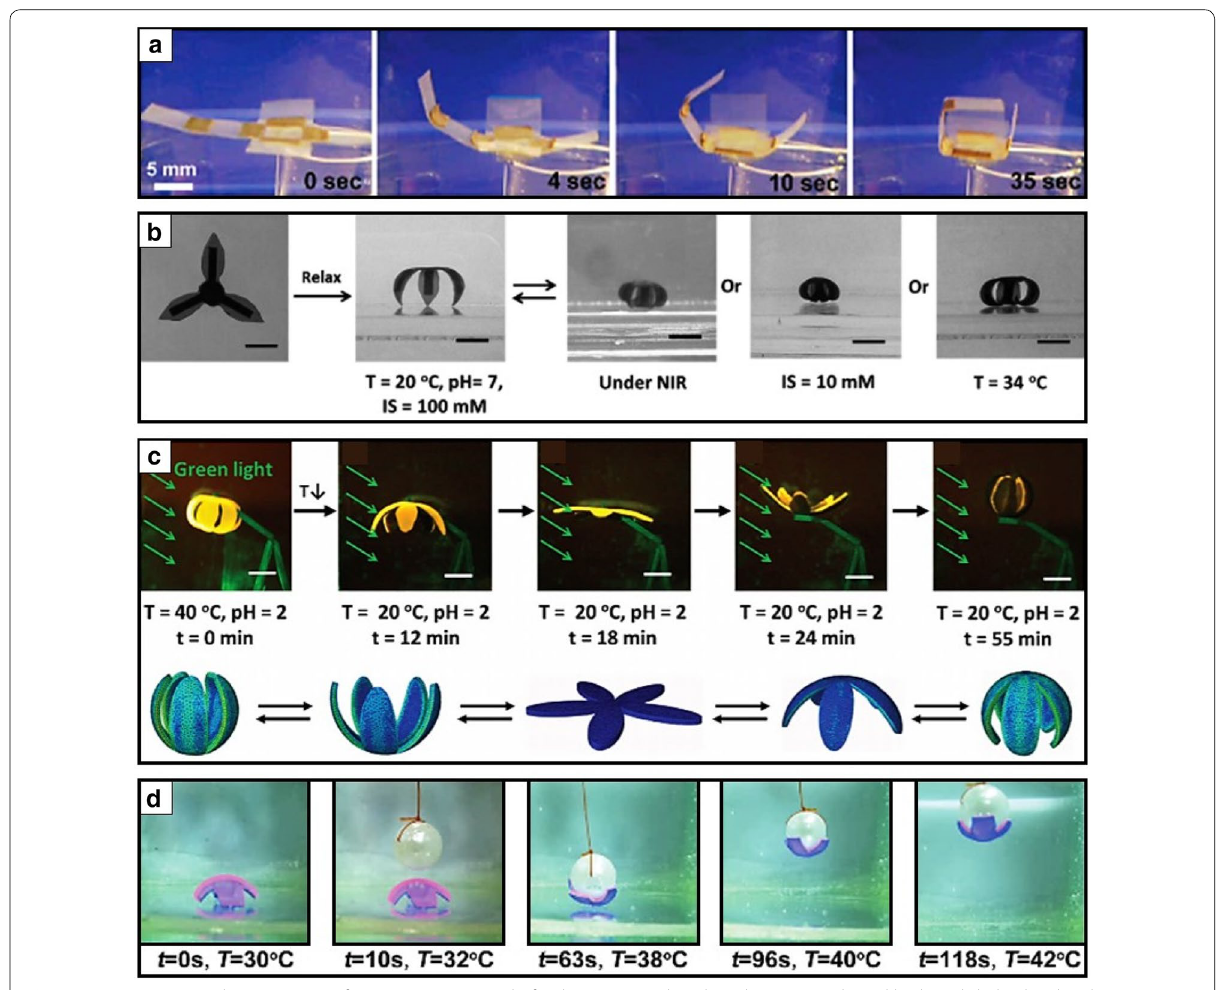
Fig. 2 Biomimetic stimuli responsive soft grippers composed of poly N -isopropylacrylamide (pNIPAM) based hydrogels hybridized with nanoparticles. a Programmable folding cube composed of single-walled carbon nanotube (SWNT)-pNIPAM and low-density polyethylene (LDPE) bilayer that actuates reversibly in water (reproduced with permission [66]. Copyright 2011, American Chemical Society). b Multi near-infrared light (NIR), ionic strength (IS), and temperature change responsive soft gripper composed of graphene oxide (GO)-pNIPAM and pNIPAM-poly(methylacrylic acid)(PMAA) bilayer (reproduced with permission [65]. Copyright 2016, Wiley–VCH). c Thermoresponsive biomimetic flower shaped fluorescent color displaying soft gripper composed of graphene oxide (GO)-pNIPAM and pH responsive perylene bisimide-functionalized hyperbranched polyethylenimine (PBI-HPEI) hybrid bilayer (reproduced with permission [68]. Copyright 2017, Wiley–VCH).